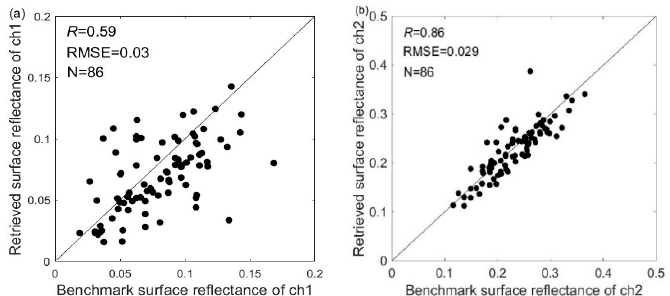
Figure 12. Comparison of the retrieved AVHRR surface reflectance and atmospheric-corrected surface reflectance using ground-based observations of the aerosol optical properties at 0.63 μ m ( a ) and 0.85 μ m ( b ), respectively. The line is the 1:1 plot. The text denotes the correlation coefficient ( 𝑅 ), the RMSE error and the number of retrievals (N).